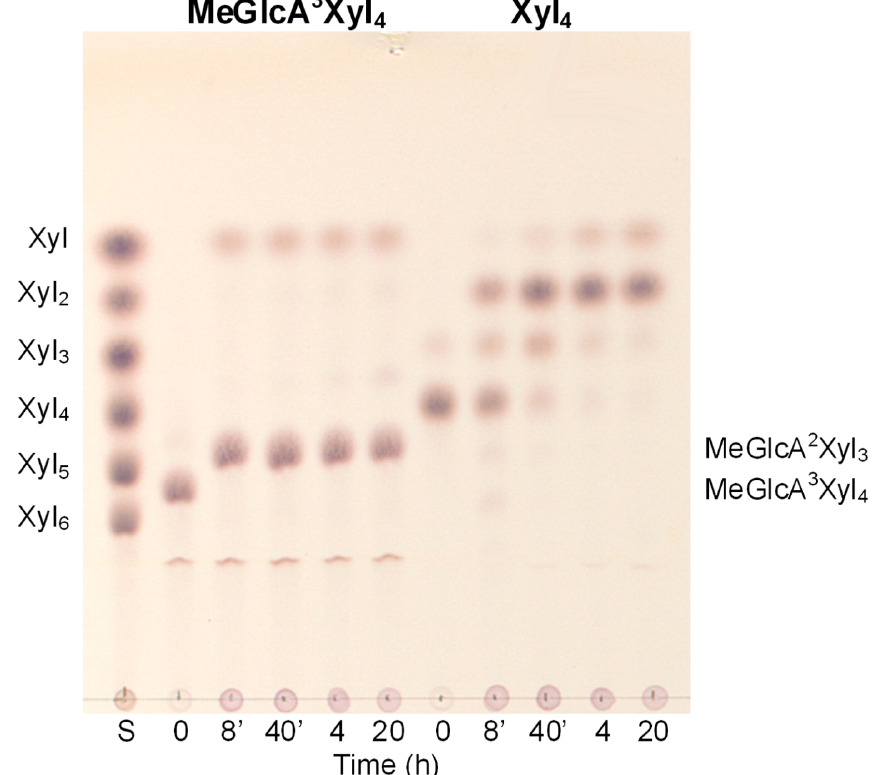
Figure 3. Time course of hydrolysis of aldopentaouronic acid MeGlcA 3 Xyl 4 and Xyl 4 by Tl Xyn30A xylanase followed by TLC. Notice the difference in the rate of the hydrolysis of the two substrates differing in the MeGlcA side residue. Eight-minute incubation of MeGlcA 3 Xyl 4 was sufficient for its complete conversion to MeGlcA 2 Xyl 3 , while Xyl 4 was consumed after several hours. S–standards of linear β -1,4-xylooligosaccharides.